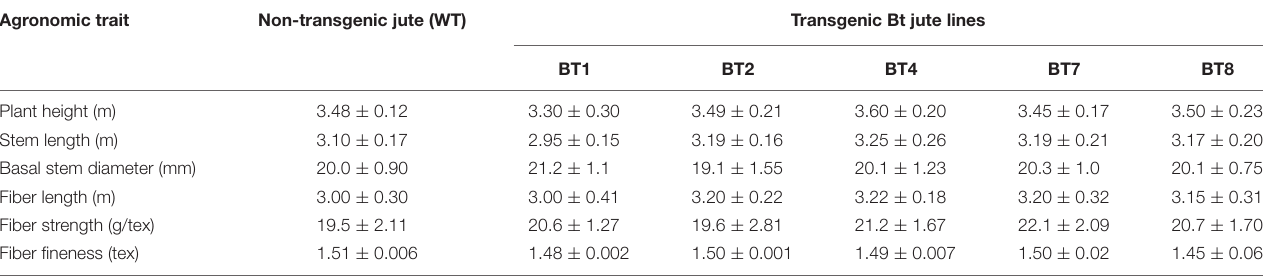
The values represent the mean of 10 progeny plants from each line ± standard error.